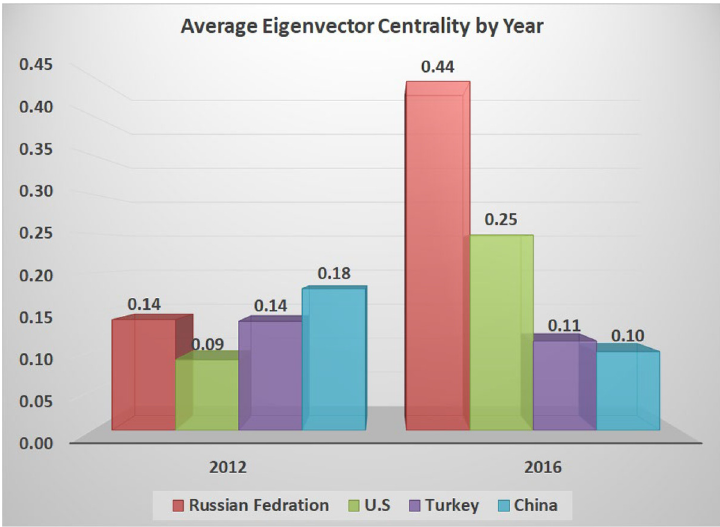
Figure 3. Average eigenvector centrality values for the key States in both